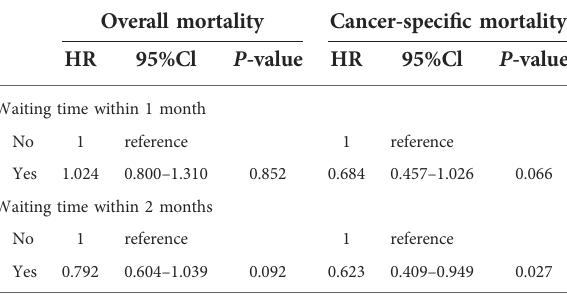
TABLE 4 Multivariable Cox regression for patients ’ mortality based on different cut-off points of waiting time. Overall